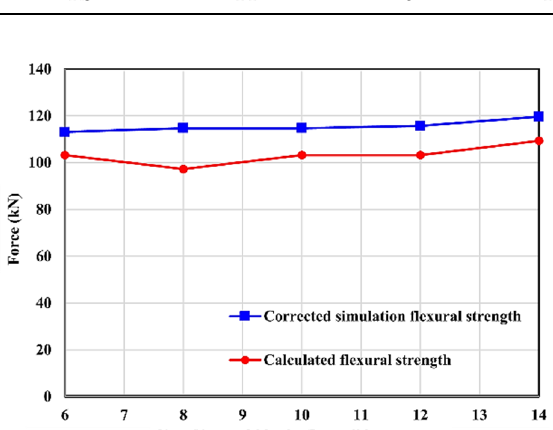
Figure 28. Simulation flexural strength versus calculated flexural strength for reinforcement distri- bution models.